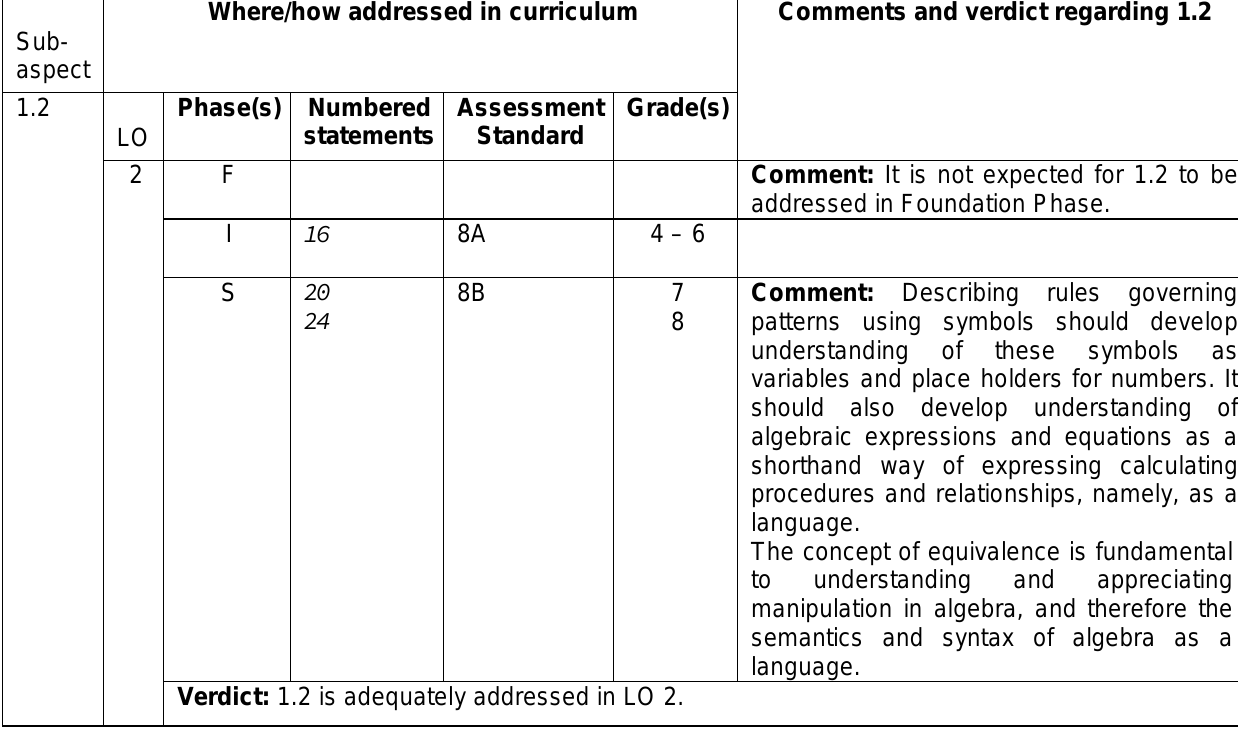
Aspect 1 (cont.): enable learners to experience and appreciate algebra as generalised arithmetic (LO2).